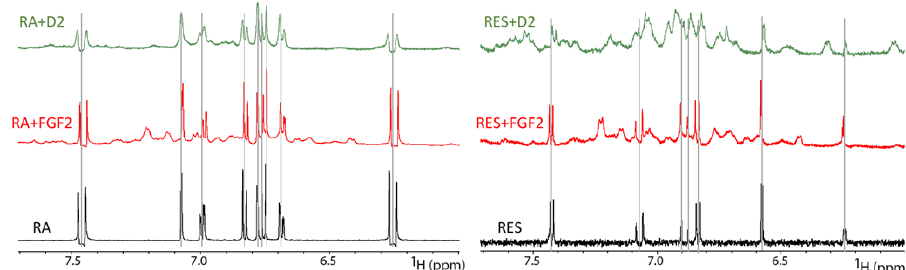
Figure 5. Comparison of 1D 1 H spectra of RA (left) and RES (right) in the presence of FGF2 ([FGF2] = 0.2 mM, red) or D2 ([D2] = 0.2 mM, green). The spectra of free ligands are shown in black as a reference. Vertical lines mark the frequencies of the free-ligand resonances.